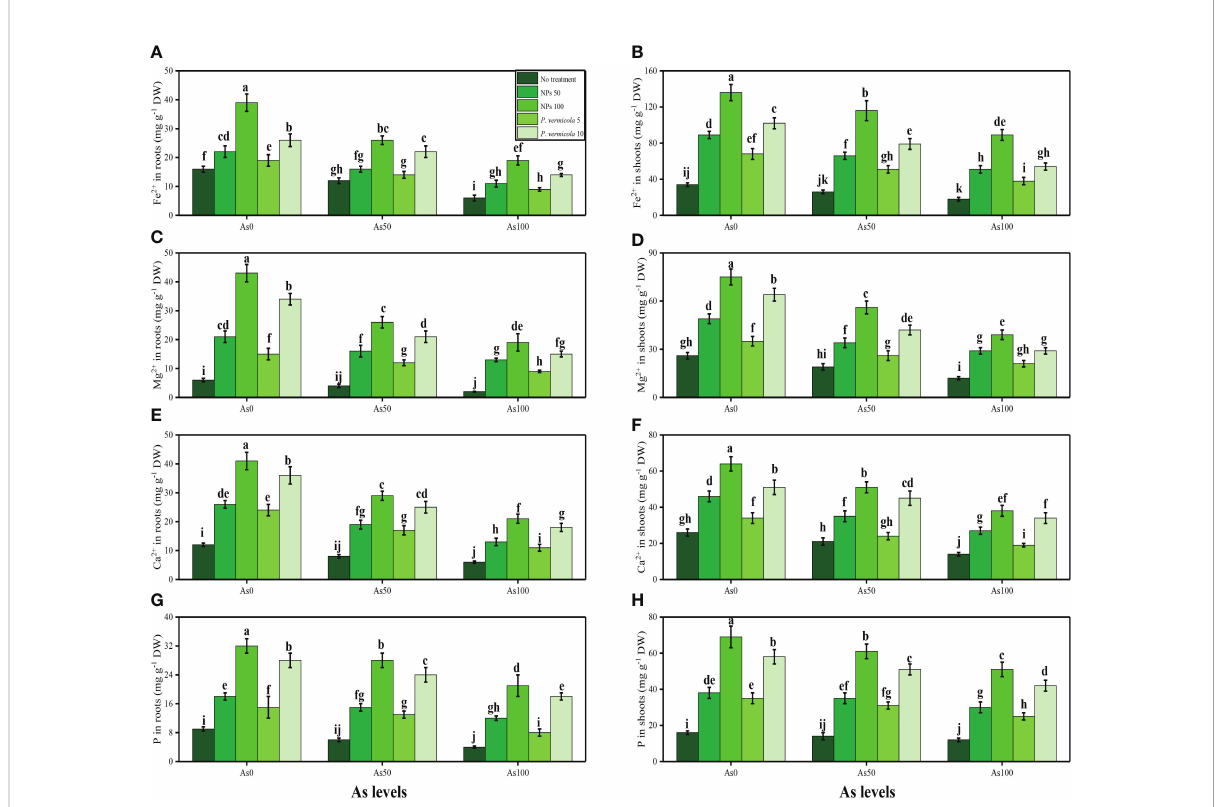
FIGURE 7 Effect of combined application of various levels of iron oxide nanoparticles (FeO-NPs) (i.e., 50 mg/l − 1 and 100 mg/l − 1 ) and plant growth- promoting bacteria ( Providencia vermicola ) (i.e., 5 ppm and 10 ppm) on iron contents in the roots (A) , iron contents in the shoots (B) , magnesium contents in the roots (C) , magnesium contents in the shoots (D) , calcium contents in the roots (E) , calcium contents in the shoots (F) , phosphorus contents in the roots (G) , and phosphorus contents in the shoots (H) of Ajwain ( Trachyspermum ammi seedlings) grown under various stress levels of arsenic (0 i.e., 0 m M, 50 m M, and 100 m M). Values are demonstrated as means of four replicates along with standard deviation (SD; n = 4). Two-way ANOVA was performed and means differences were tested by Tukey ’ s highly signi fi cant difference post-hoc test ( p < 0.05). Different lowercase letters on the error bars indicate signi fi cant difference between the